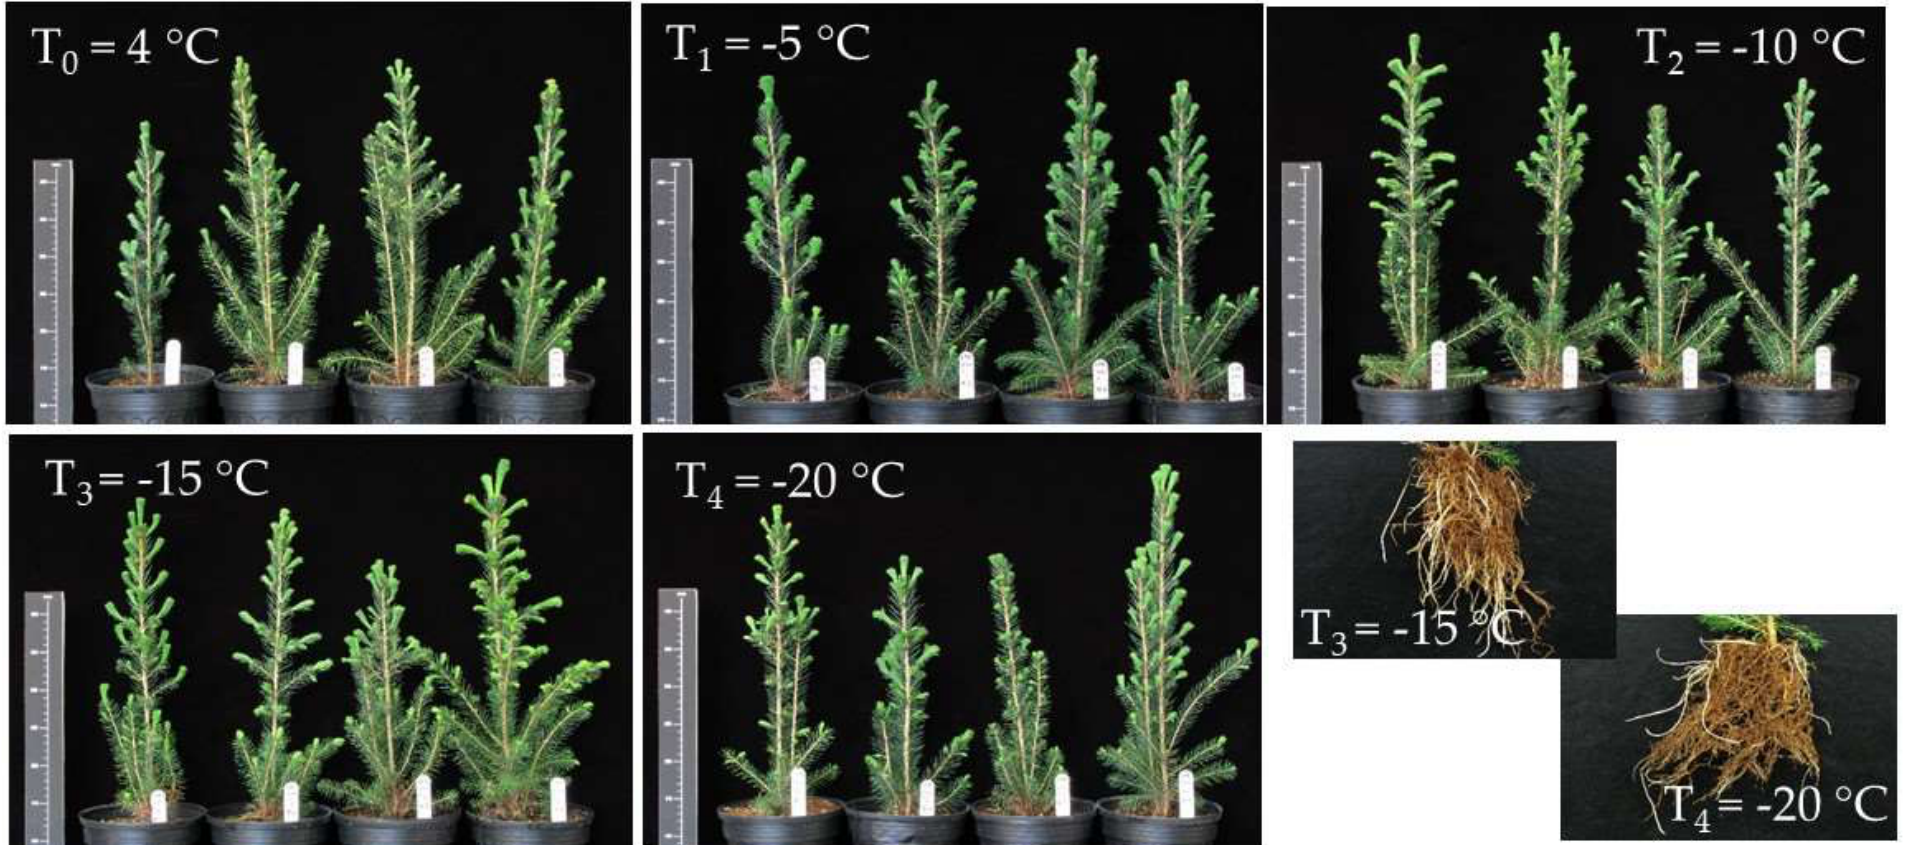
Figure 4. Bud burst of all buds of main stems and lateral branches of all white spruce (2 + 0) seedlings in response to different temperatures (T 0 , T 1 , T 2 , T 3 , and T 4 ) and after 21 days of growth during the recovery period under optimal greenhouse growing conditions. Example of new root initiation in response to the two freezing temperatures (T 3 and T 4 ) and optimal growing conditions.